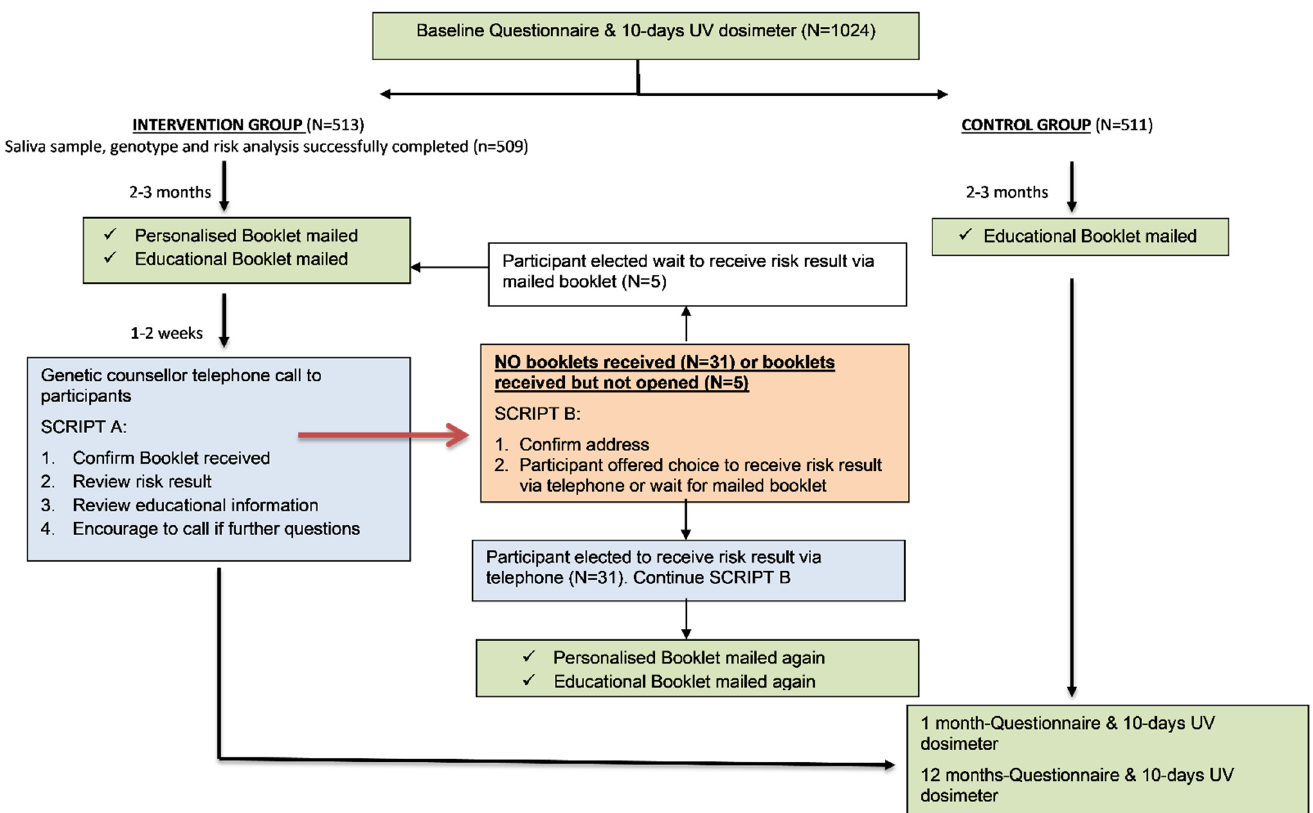
Figure 1. Participant flow for the provision of the intervention and control materials in the Melanoma Genomics Managing Your Risk Study.